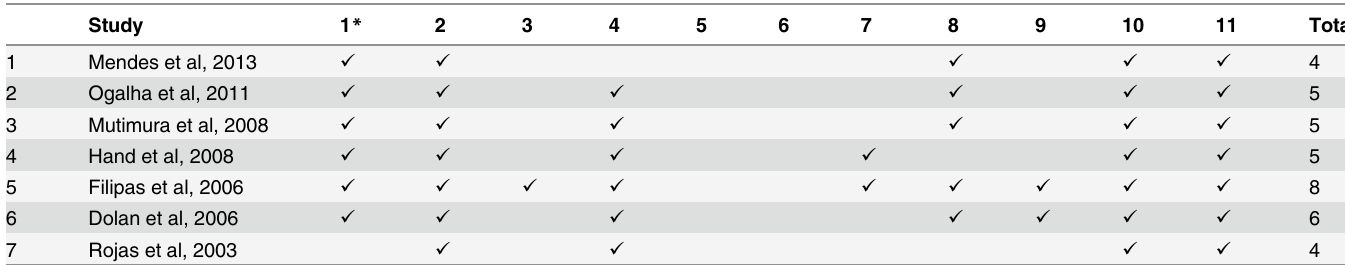
Table 2. Study quality on the PEDro scale.